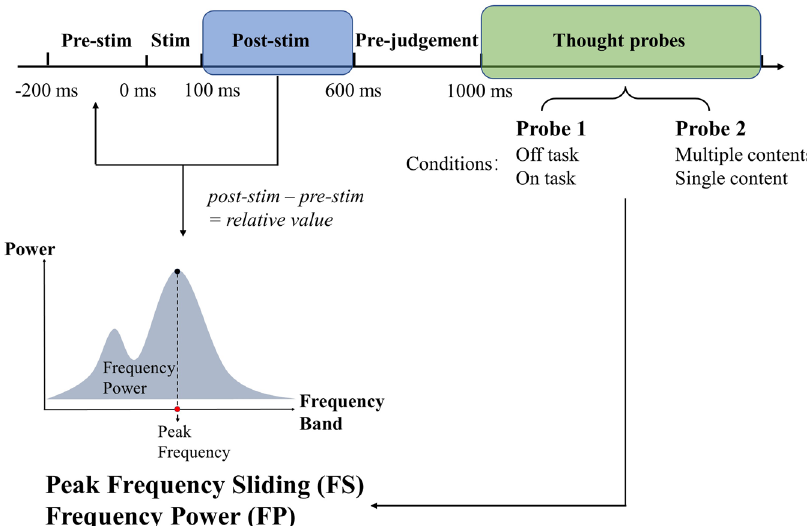
Fig. 3 EEG analysis schema. EEG signals were fi rst transferred to peak frequency sliding (FS) and frequency power (FP), then the average of pre-stimulus period ( − 200 – 100 ms) was subtracted from post-stimulus period (100 – 600 ms) to obtain the relative values. Alpha (8 – 13 Hz) and theta (5 – 8 Hz) post- stimulus relative values were compared between conditions, i.e., the different thought types, using